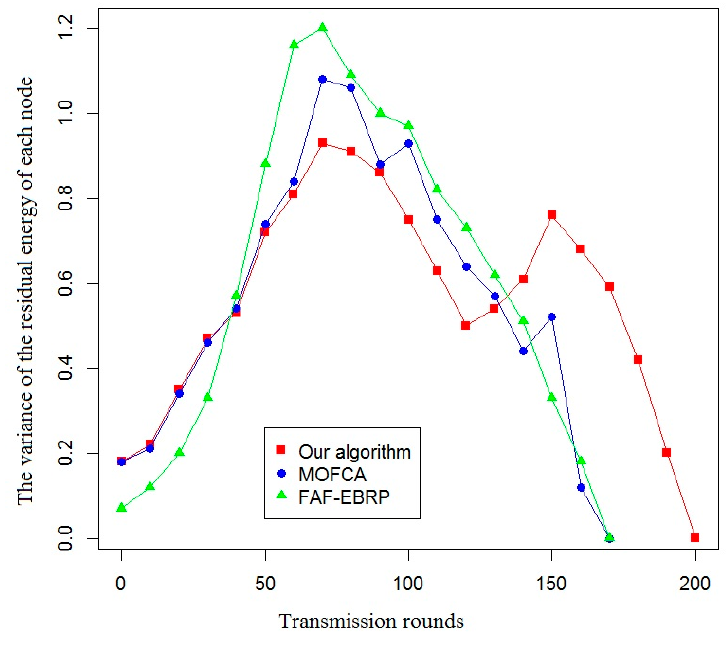
Sensors 2020 , 20 , x FOR PEER REVIEW Figure 9. Comparison of the variance of the residual energy of each node. Figure 9. Comparison of the variance of the residual energy of each node.